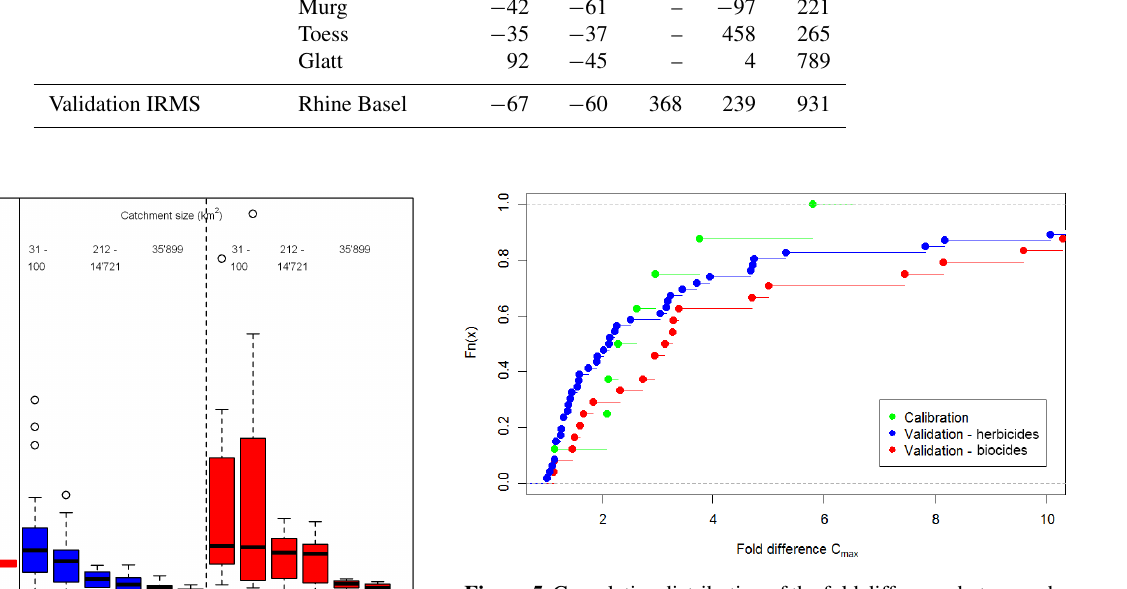
Figure 5. Cumulative distribution of the fold difference between ob- served and simulated concentrations C max of all compounds during the calibration and validation phase.